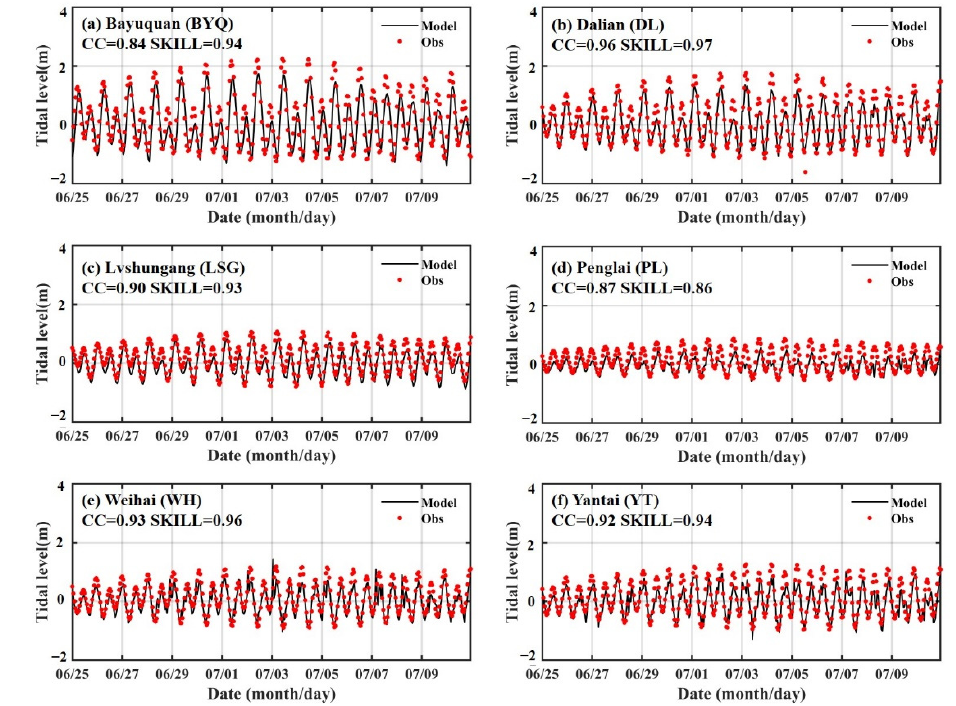
Figure 4. The comparison between computed (red dots) and measured (black solid line) water levels at different stations. ( a ) Bayuquan, ( b ) Dalian, ( c ) Lvshungang, ( d ) Penglai, ( e ) Weihai, and ( f ) Yantai.